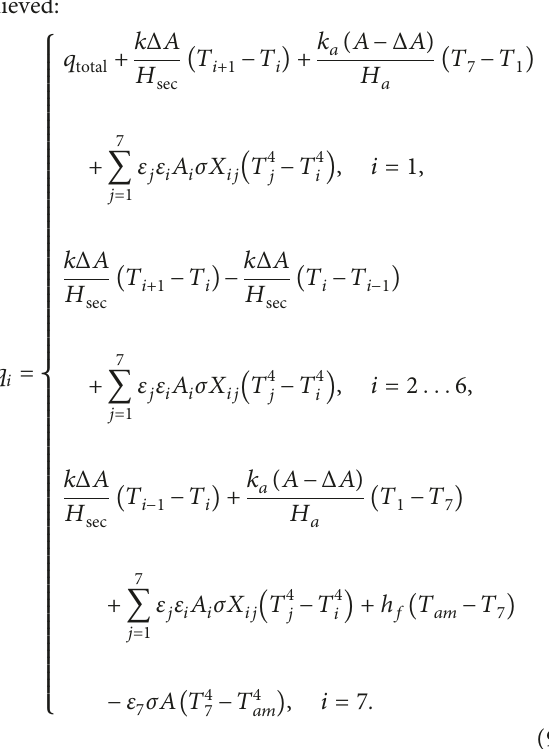
Figure 1: Honeycomb cell